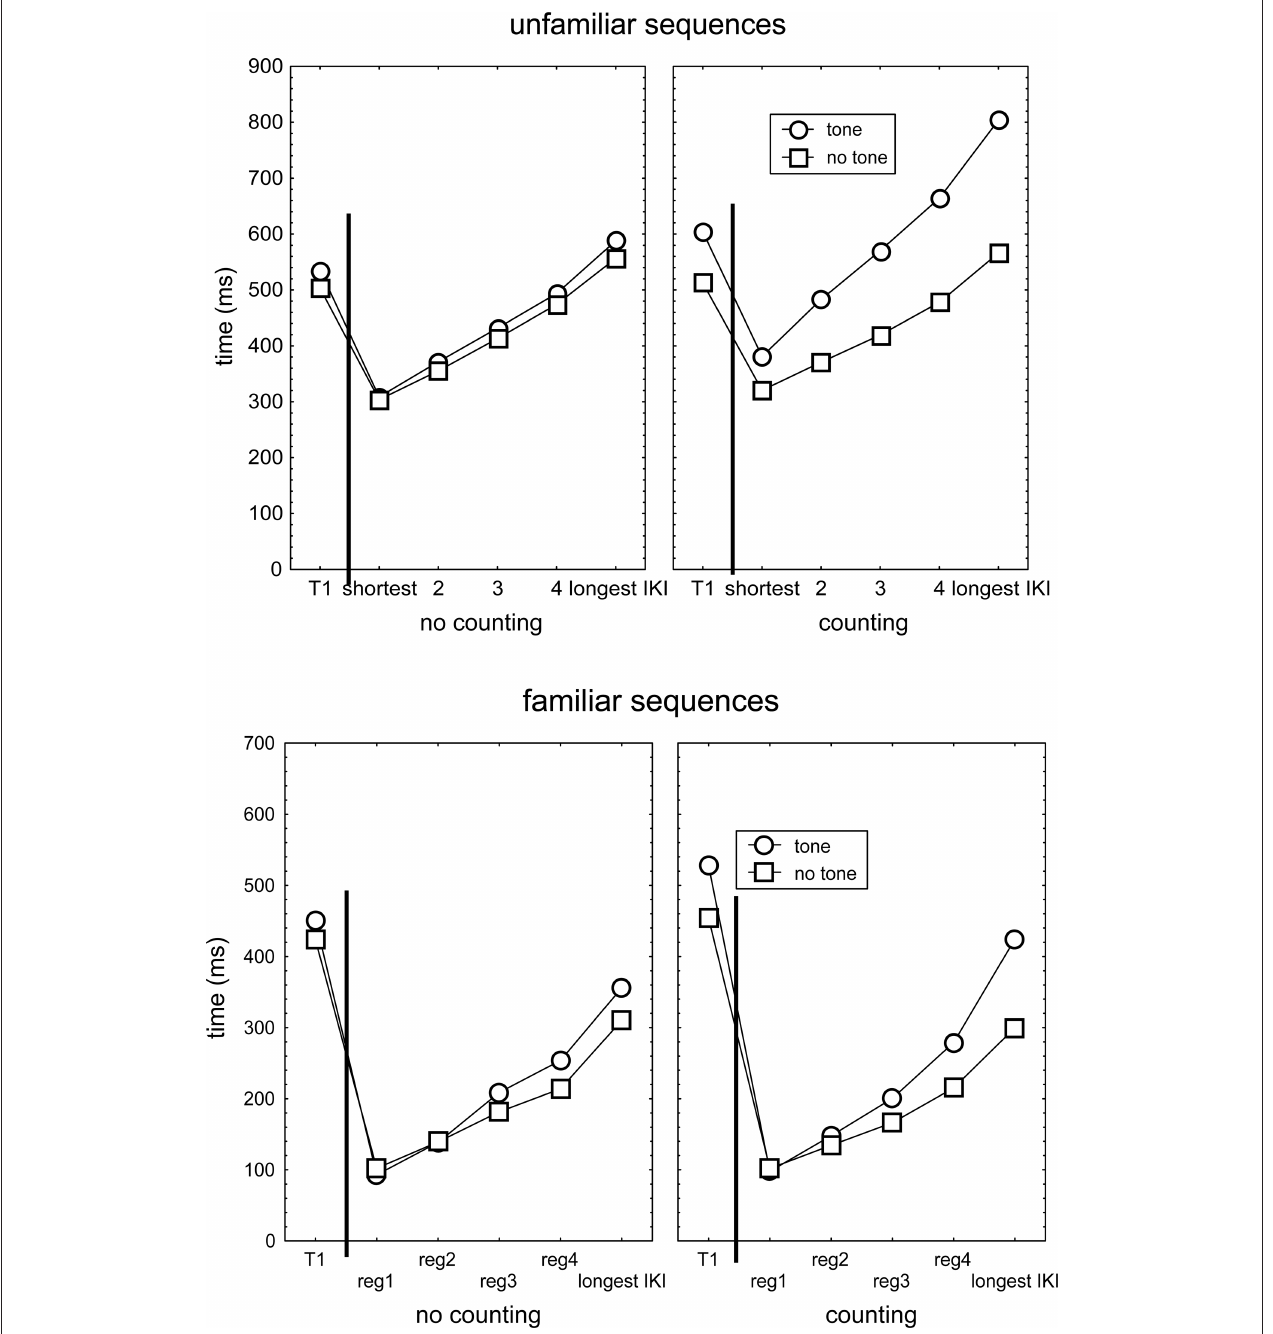
actually presented, and in sequences which no tone was presented. IKIs had first been sorted for each individual participant as function of their duration and then averaged across